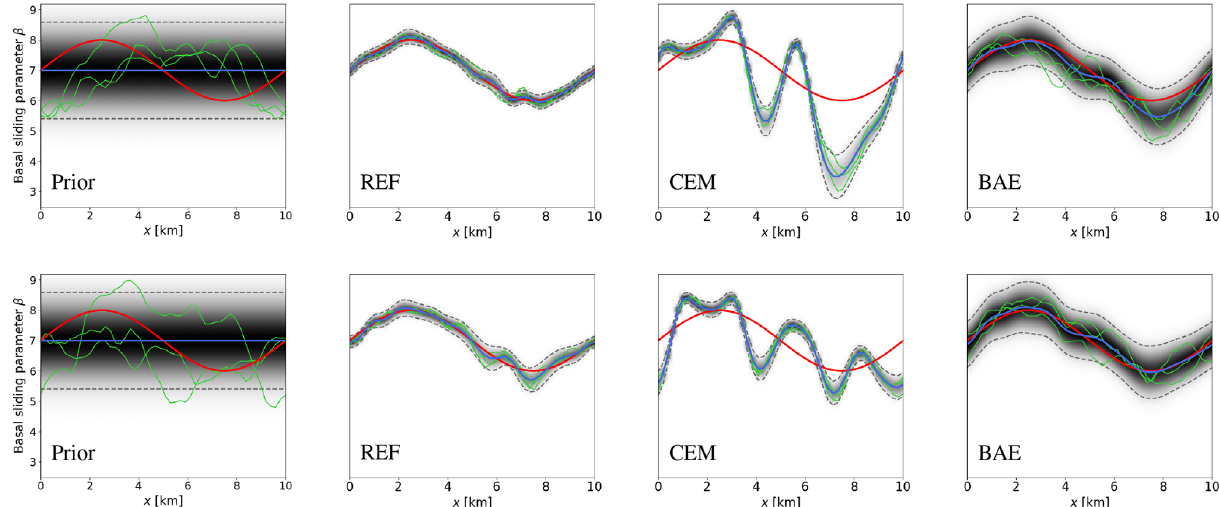
Figure 7. Prior and MAP estimates of the basal sliding parameter for Example 1. Top row: Example 1a prior (far left), accurate/reference (REF) case (center left), conventional error model (CEM) case (center right), and Bayesian approximation error (BAE) case (far right). The bottom row shows the same plots for Example 1b. In each plot, the mean of the distribution (blue line) is shown along with the true basal sliding parameter, β true (red line), three samples from the respective distributions (green lines), the marginal distribution (shaded) with darker shading indicating higher probability, and the ± 2 (approximate) standard deviation intervals (dashed black